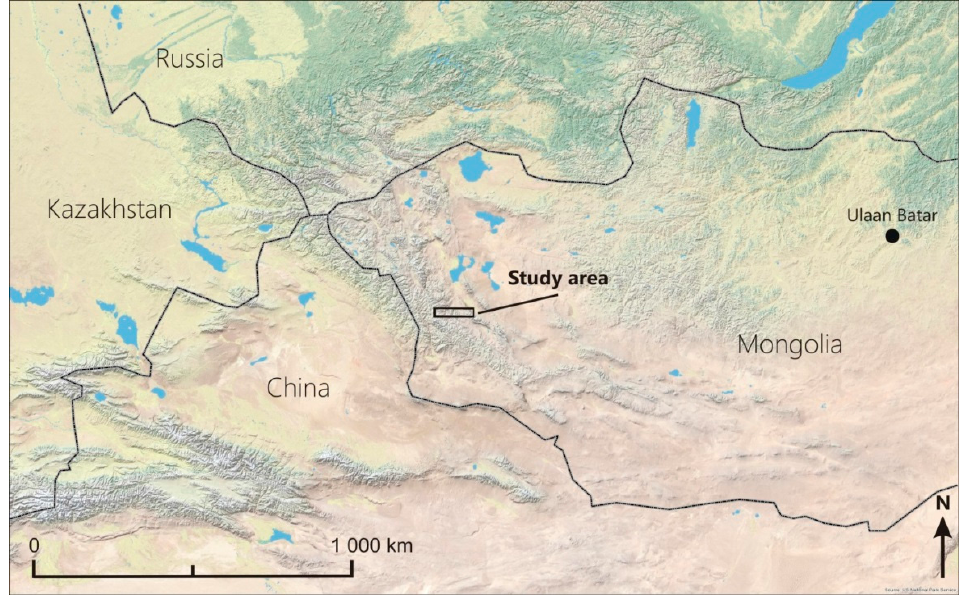
Figure 1. Geographic scheme of the geological mapping area.